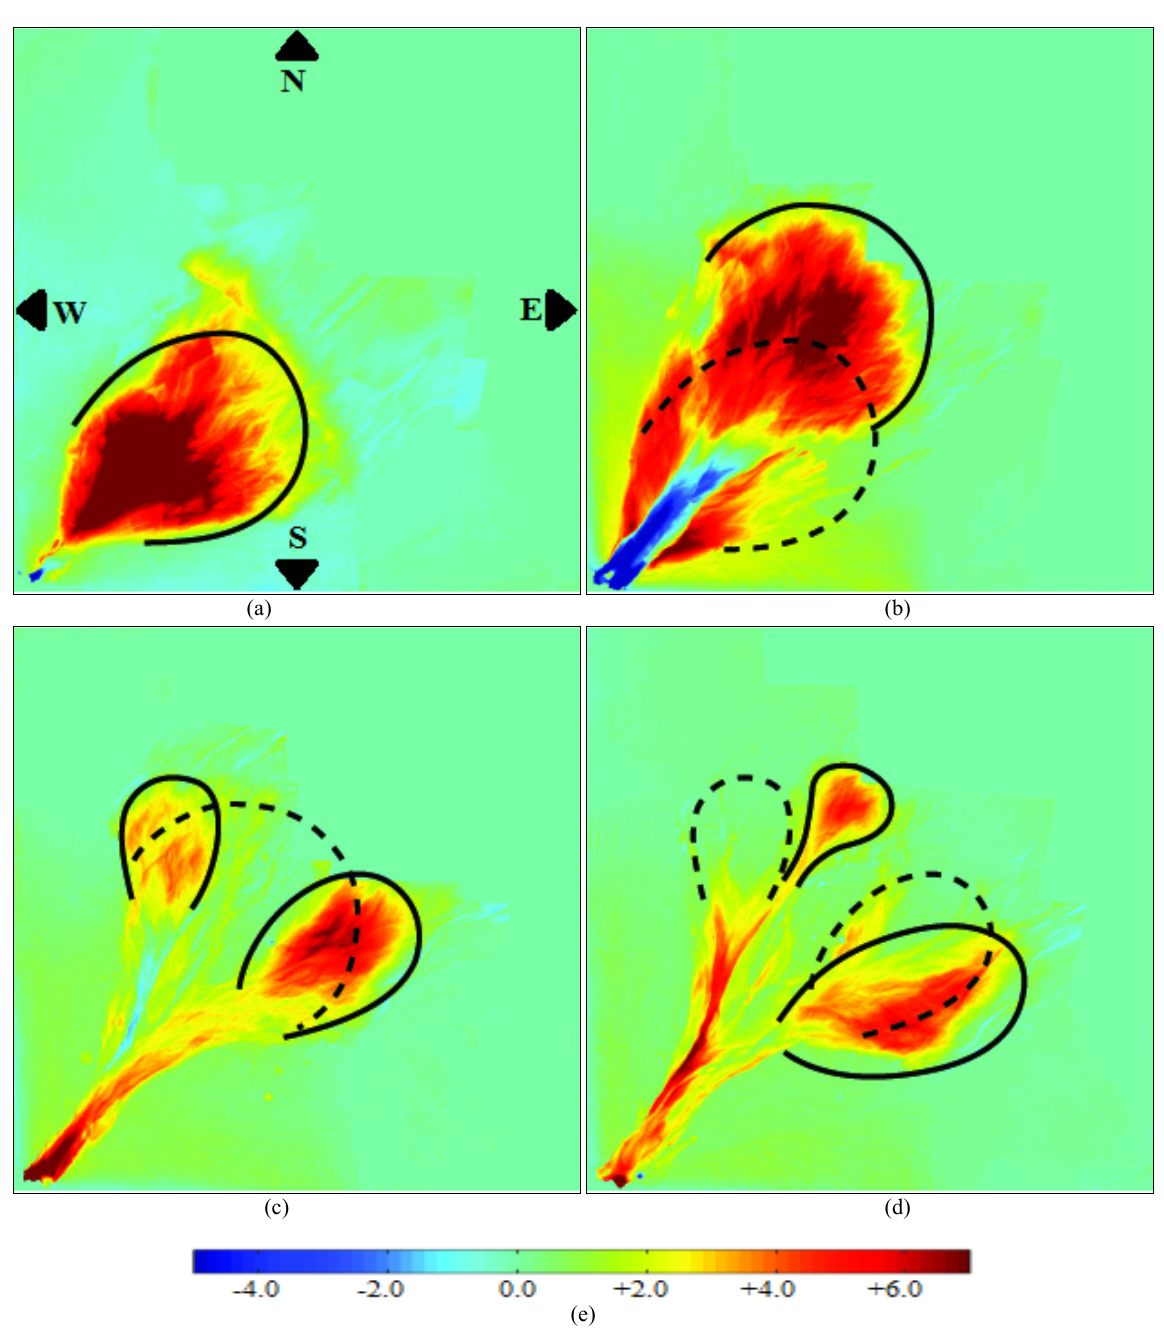
Figure 6. Spatial distribution of the sedimentation and erosion between the successive epochs (a) epoch1–epoch0, (b) epoch2– epoch1, (c) epoch3–epoch2, (d) epoch4–epoch3. The residual bar is in millimetres unit